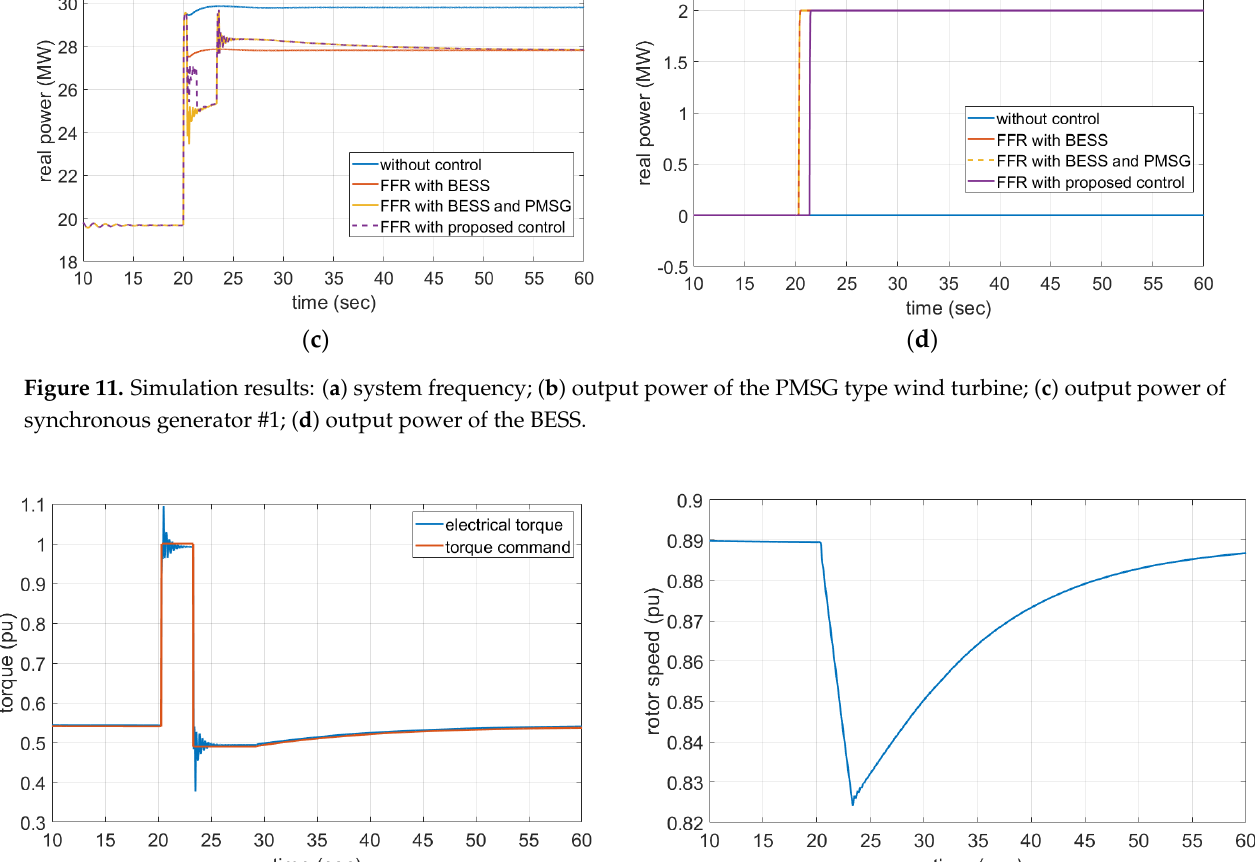
Figure 12. Simulation results of the PMSG type wind turbine: ( a ) electrical torque and torque command; ( b ) rotor speed.